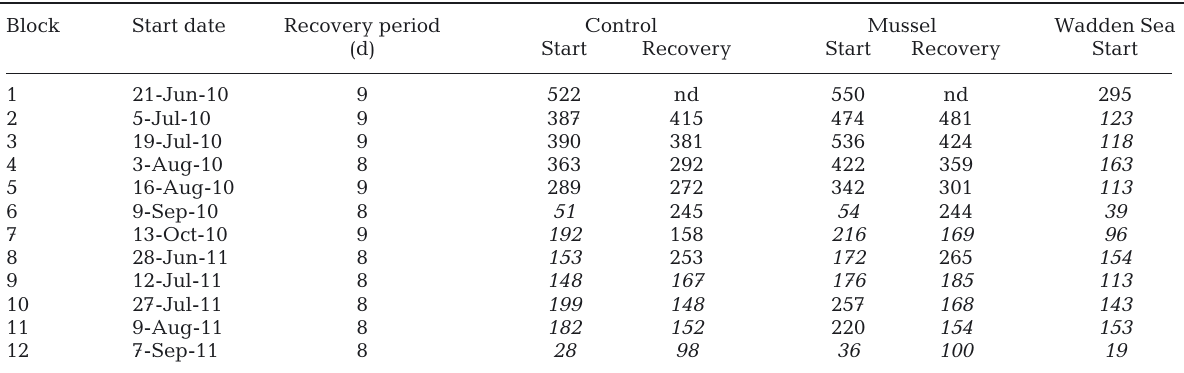
Table 2. Mean column irradiances (Eq. 1) in the mesocosms (depth, z = 0.8 m) at the start and end of the recovery period. Aver- age column irradiances in the western Wadden Sea (see Fig. 1) are also given for the start date of each experiment. Light above 200 µE m −2 s −1 is considered saturating for phytoplankton growth (Gieskes & Kraay 1975, Colijn 1982). Non-saturating levels are in italics ; nd: not